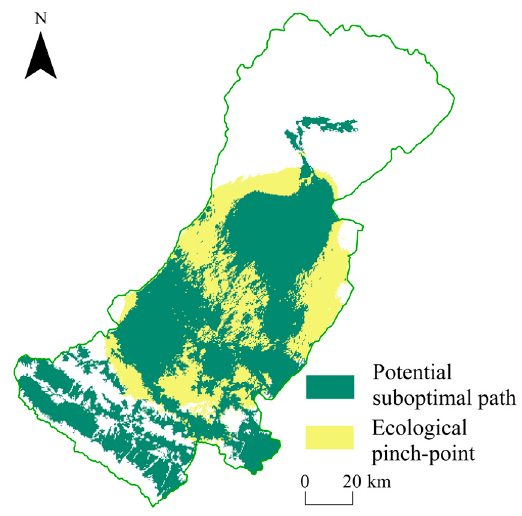
Figure 8. Distribution of Sub-optimal Path and “Pinch Points”.